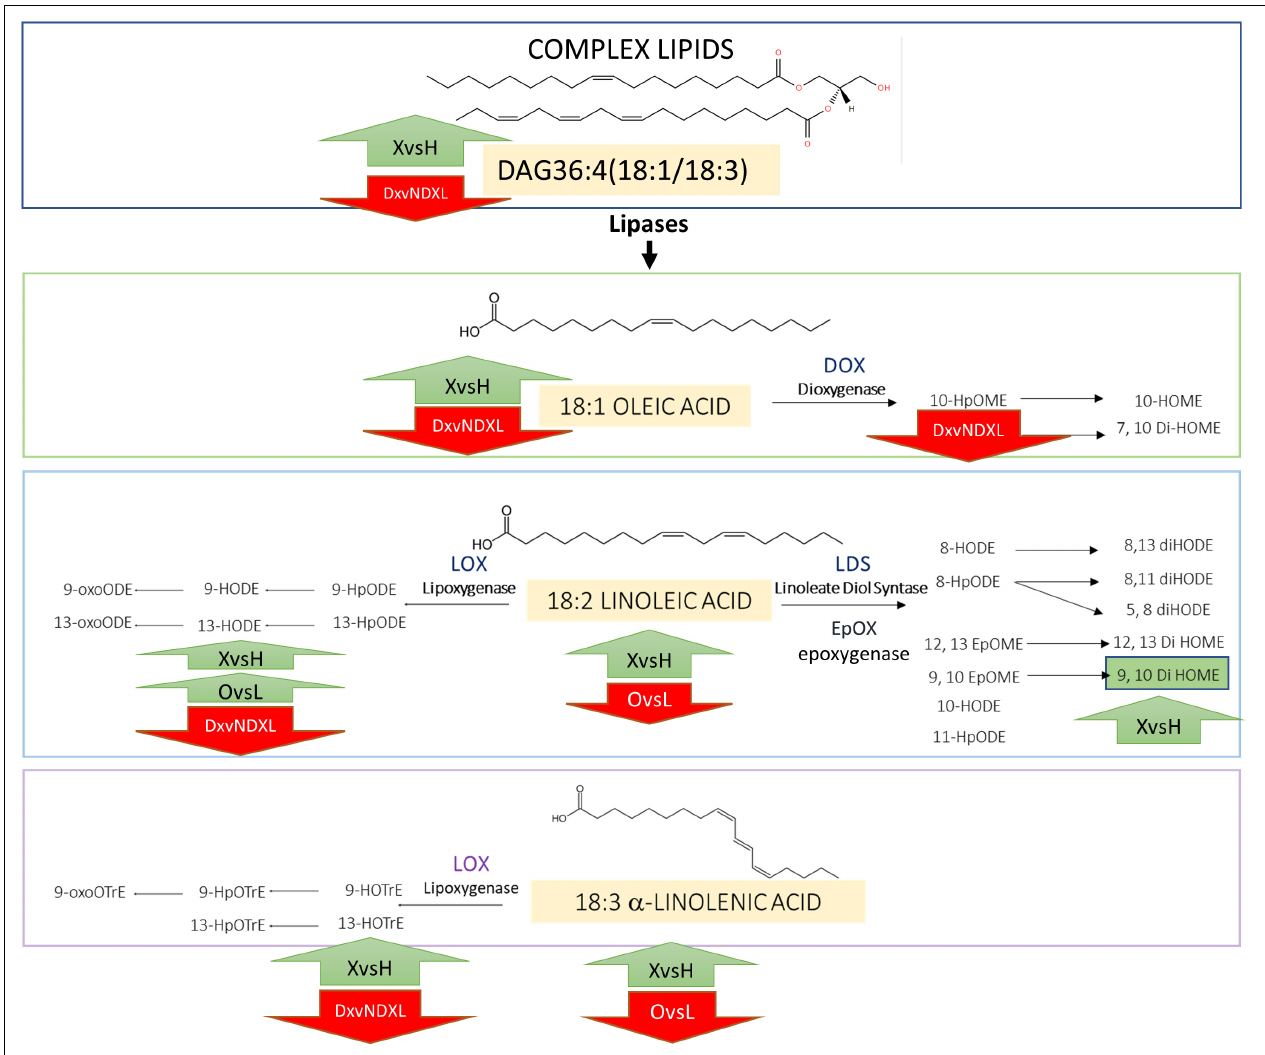
FIGURE 3 | Proposed outline of the lipid metabolism in the two cultivars Ogliarola salentina (O) and Leccino (L) in healthy (H) and in X. fastidiosa -infected (X) olive trees; these latter treated (DX) or untreated (NDX) with Dentamet R (cid:13) . Complex lipids (e.g., diacylglycerides) cleaved by lipases produce free fatty acids (e.g., oleic/linoleic/linolenic acids) that, in turn, are oxidized by enzymes like lipoxygenases (LOX) and dioxygenases (DOX; LDS) and epoxygenases (EpOX) to produce oxylipins [e.g., 9-hydroxyoctadecenoic acid (9-HODE) and 10-hydroperoxyoctamonoenoic acid (10HpOME)].